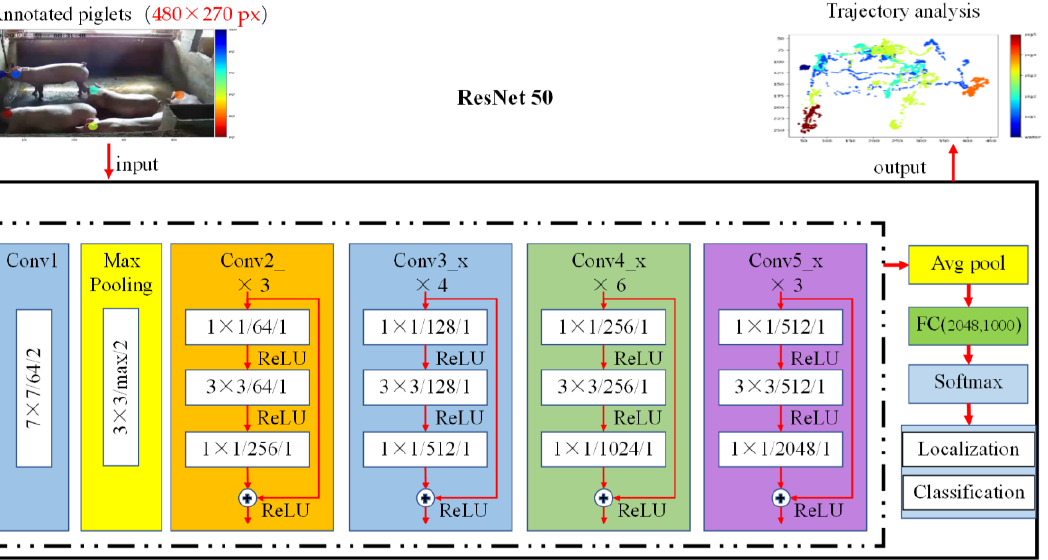
Figure 7. ResNet50 structure.